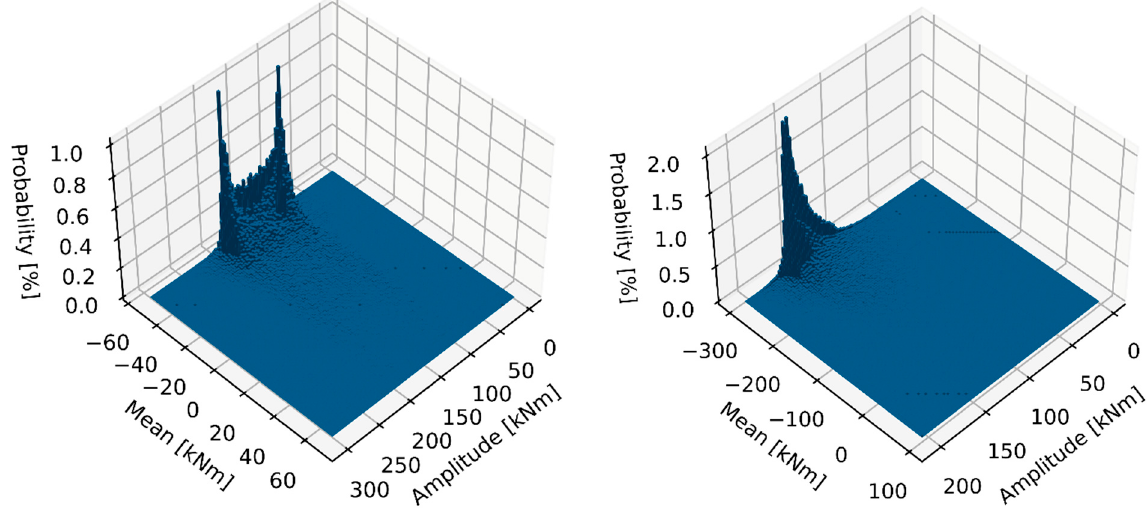
Figure 12. Rainflow counting of the blade root moments.